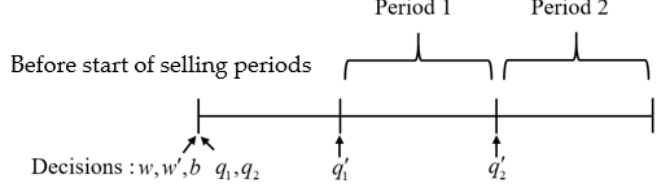
Figure 3. Timeline of decision making in Model 3.